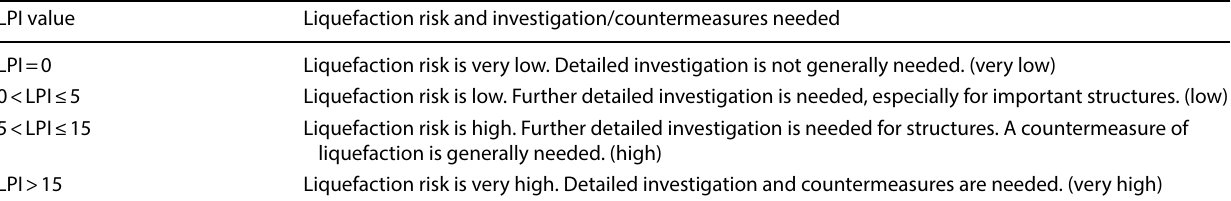
Table 3 Liquefaction risk analysis based on the liquefaction potential index [28, 29] LPI value Liquefaction risk and investigation/countermeasures needed LPI = 0 Liquefaction risk is very low. Detailed investigation is not generally needed. (very low) 0 < LPI ≤ 5 Liquefaction risk is low. Further detailed investigation is needed, especially for important structures. (low) 5 < LPI ≤ 15 LPI >